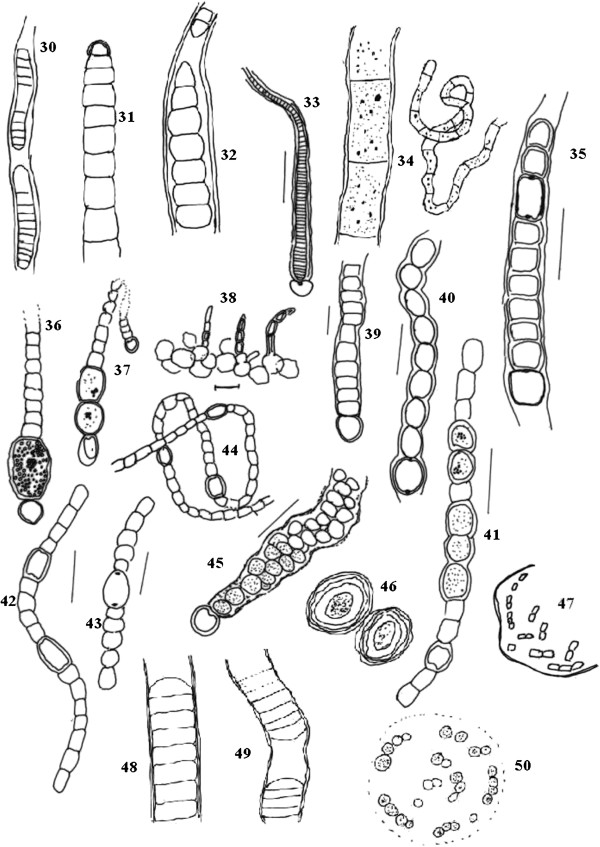
Camera Lucida diagram, of cyanobacterial species 30. Phormidium purpurascans 31. Phormidium32. Phormidium33. Calothrix braunii34.  Phormidium sp. 35.  Microchaete aequalis 36.  Cylindrospermum muscicola 37.  Cylindrospermum sp. 38.  Fischerella muscicola 39. Microchaete sp.40. Microchaete sp.41. Nostoc spongiforme42.  Nostoc commune 43.  Nostoc muscorum 44.  Nostoc carneum 45.  Nostoc punctiforme 46. Aphanothece microscopica47. Aphanothece microscopic48. Lyngbya sp.49. Lyngbya sp.50. Chroococcus sp. Scale bar 10 μm.